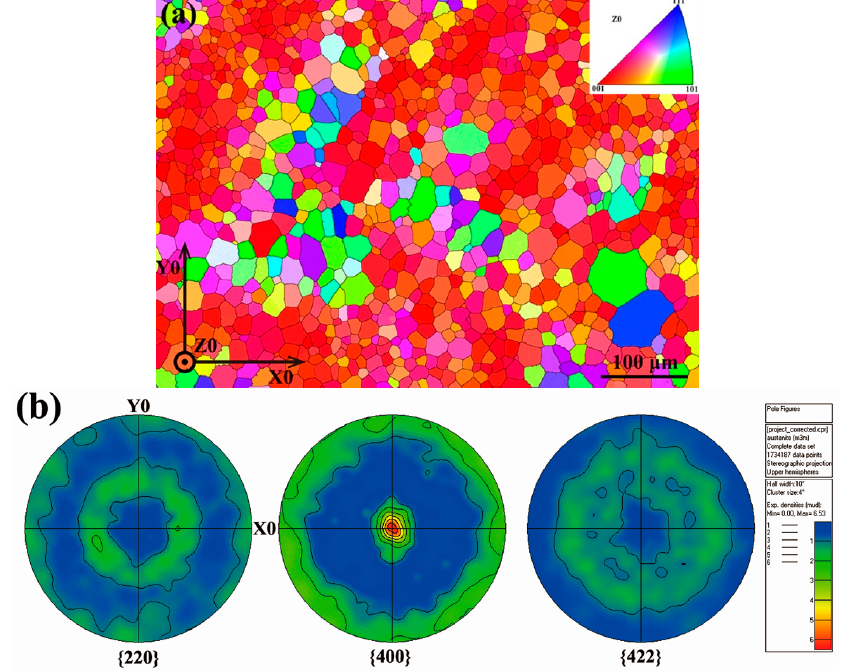
Figure 8. ( a ) Electron backscatter diffraction (EBSD) orientation map of ribbon plane for the Ni 53 Mn 22 Ga 25 ribbons; and ( b ) corresponding {2 2 0} A , {4 0 0} A and {4 2 2} A pole figures. X0//ribbon length (rolling) direction, Z0 ⊥ ribbon plane [52].